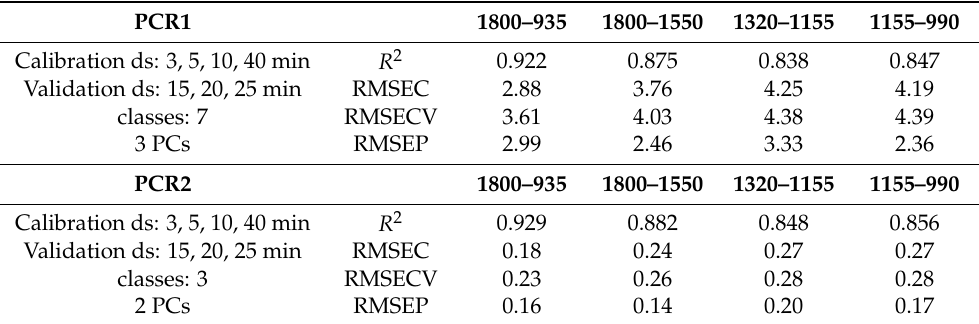
Figure 4. Results for the regression model PCR1 calculated for the 1800–935 cm − 1 region. Data were trained against calculated %B-form on the 3-, 5-, 10-, and 40-min spectra and then validated by the 15-, 20-, and 25-min spectra. For details see Table 2. Table 2. The summary of the PCR models and obtained values for goodness-of-fit parameters which include R 2 values and errors, the root-mean-square error of calibration (RMSEC), cross-validation (RMSECV), and validation (RMSEP). The abbreviation used for datasets is ds. The PCR1 model was trained with respect to seven distinct desiccation times (seven classes), from 3 to 40 min, while PCR2 was trained with respect to the level of B-form: class 1 (40%, 3 min film), class 2 (60%, 5 min film) and class 3 (75%, 10–40 min films). The respective spectral regions (in cm − 1 ) included in the model are indicated in the